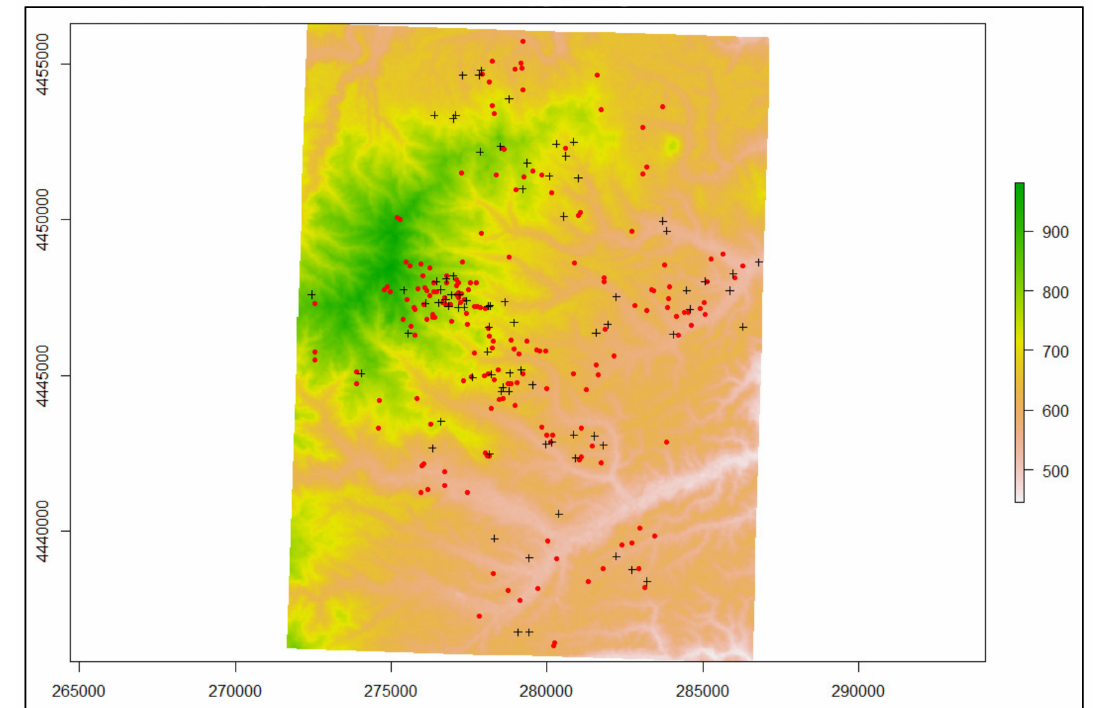
Figure 2. A digital elevation model (DEM) of the study area along with the training data locations in red circles and testing data locations in black